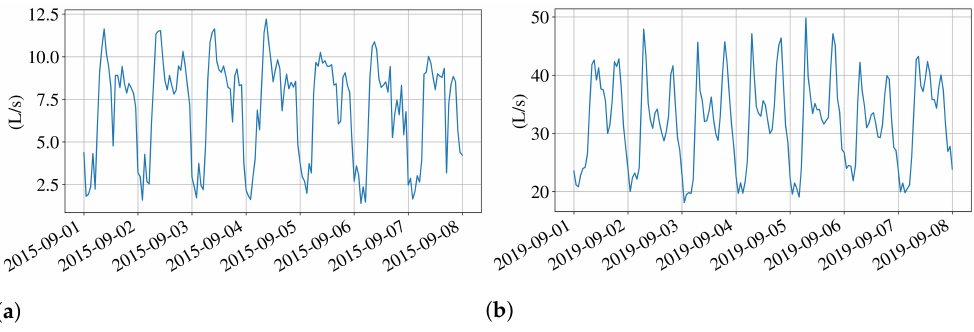
Figure 2. A weekly view of the two time series. ( a ) and ( b ) show the intra-daily behaviour of ts 1 and ts 2,